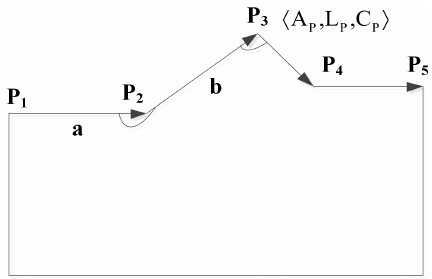
Figure 2. Sketch of shape parameter